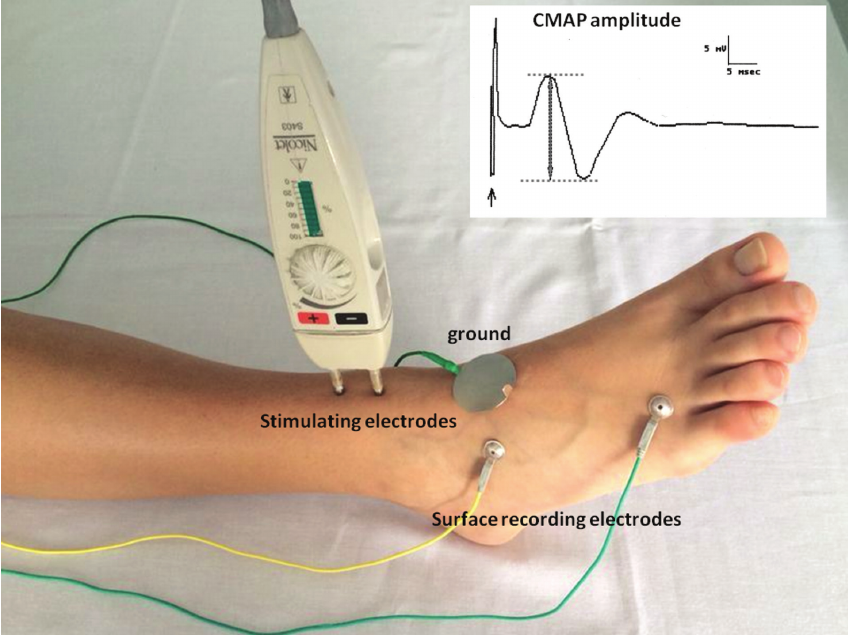
Figure 1. Schematic representation of the peroneal simplified electrophysiological test (PENT). A normal compound muscle action potential (CMAP) amplitude is